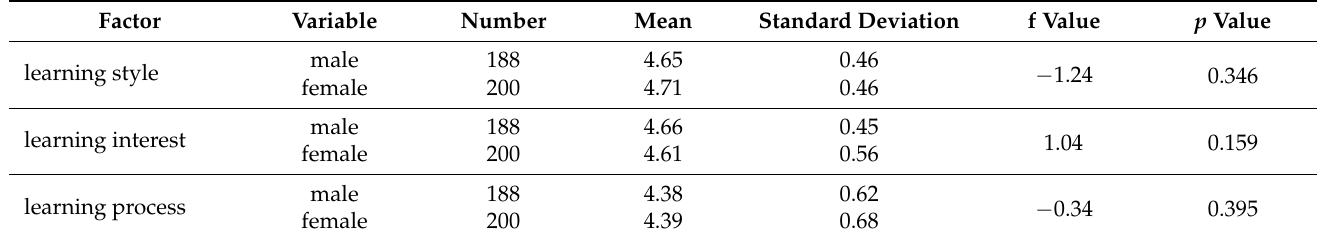
Table 2. The difference in learning satisfaction of students by gender variable.